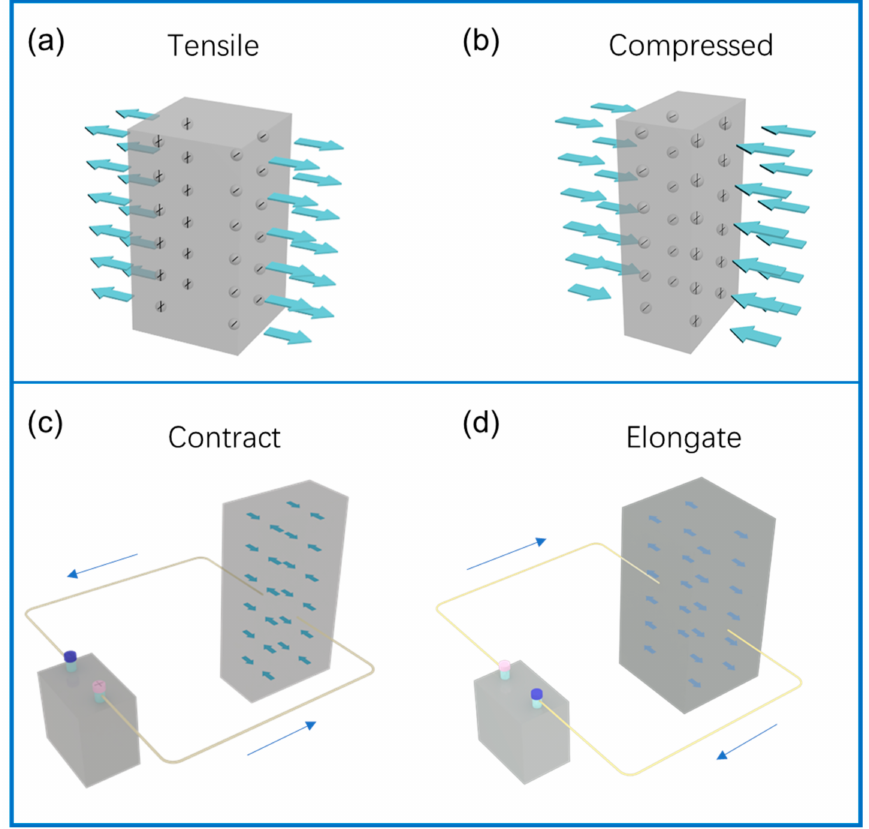
Figure 1. Schematic diagram of positive piezoelectric effect and negative piezoelectric effect. ( a , b ) show the positive piezoelectric effect exerted by compressive and tensile forces, respectively, the arrows represent tensile and compressive forces. ( c , d ) represent the negative piezoelectric effect, which causes the piezoelectric material to shrink and elongate, respectively, the arrow represents the direction of the